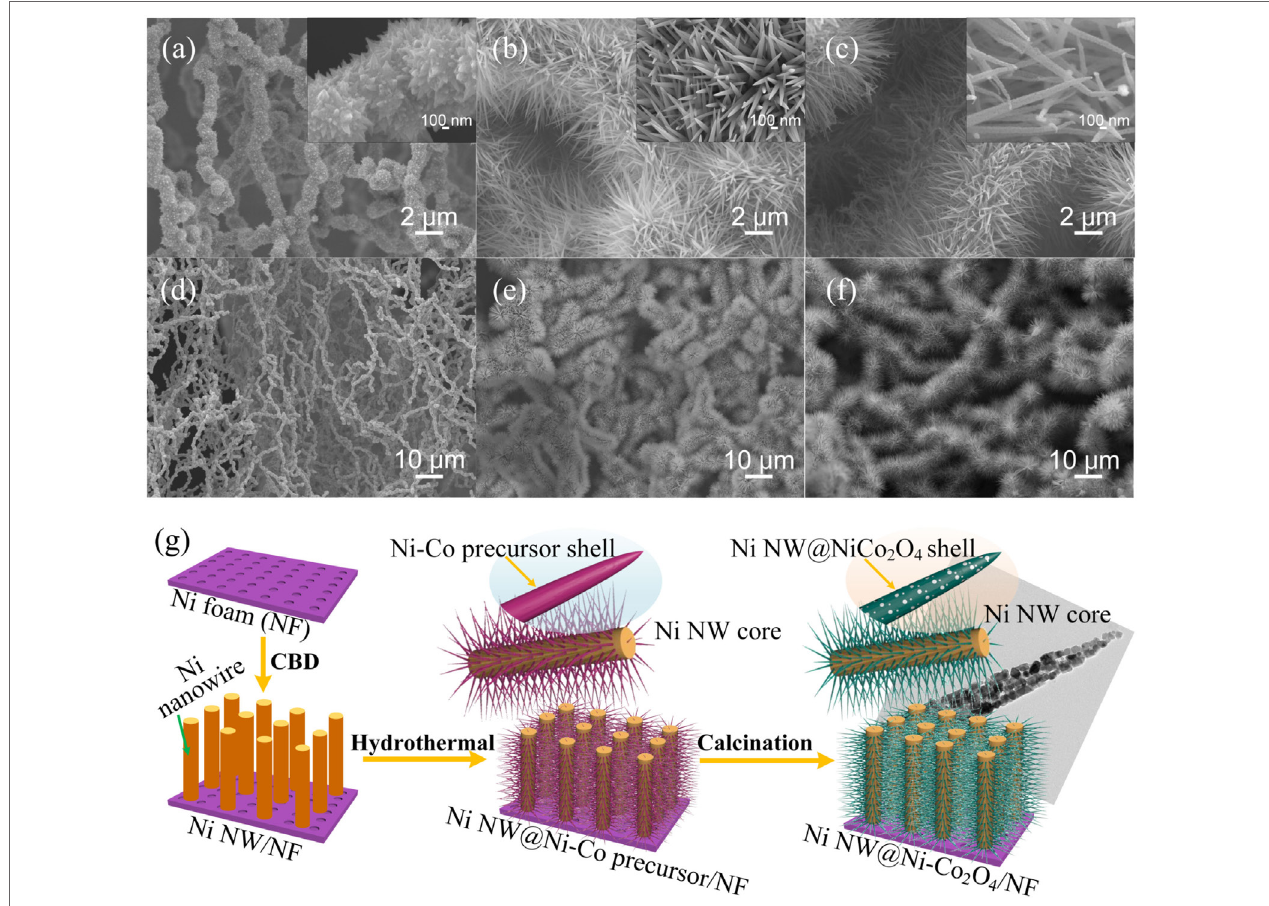
FigUre 2 | (a,D) Scanning electron microscope (SEM) images of Ni MW/NF. (B,e) SEM images of Ni NW@Ni–Co precursor/NF. (c,F) SEM images of Ni NW@